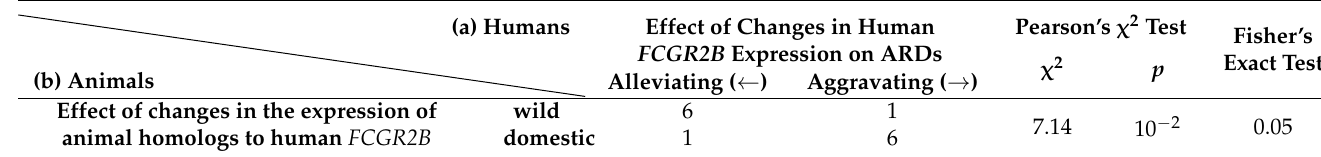
Table 10. Correlations between the effects of unidirectional changes in the expression ( a ) of the human FCGR2B gene on ARD severity in humans and ( b ) of its animal homologs on the microevolutionary events leading to domestic and wild